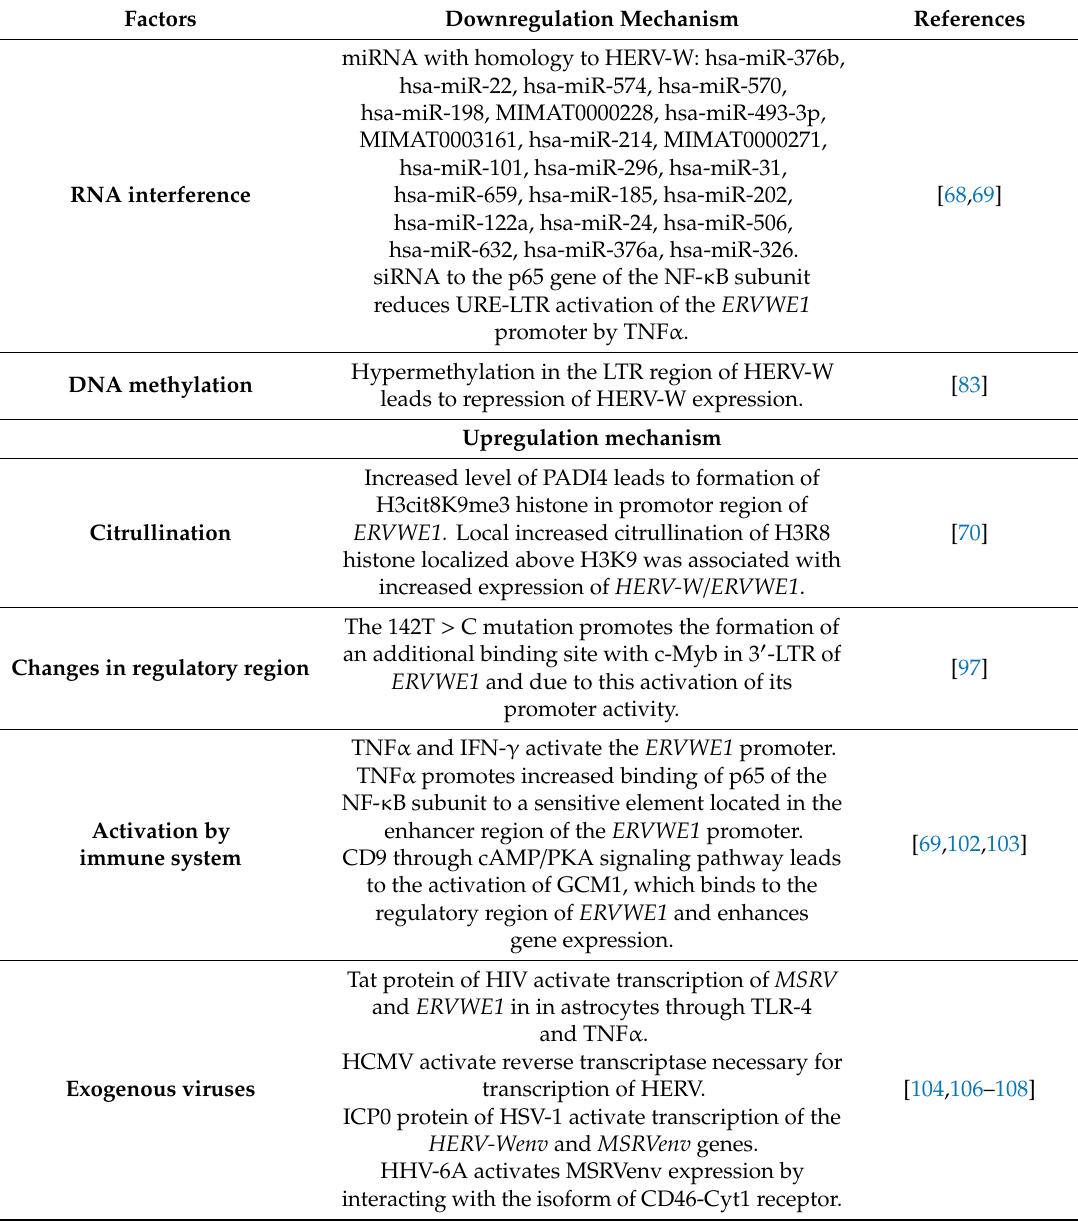
Table 1. Possible downregulation and upregulation mechanisms HERV-W